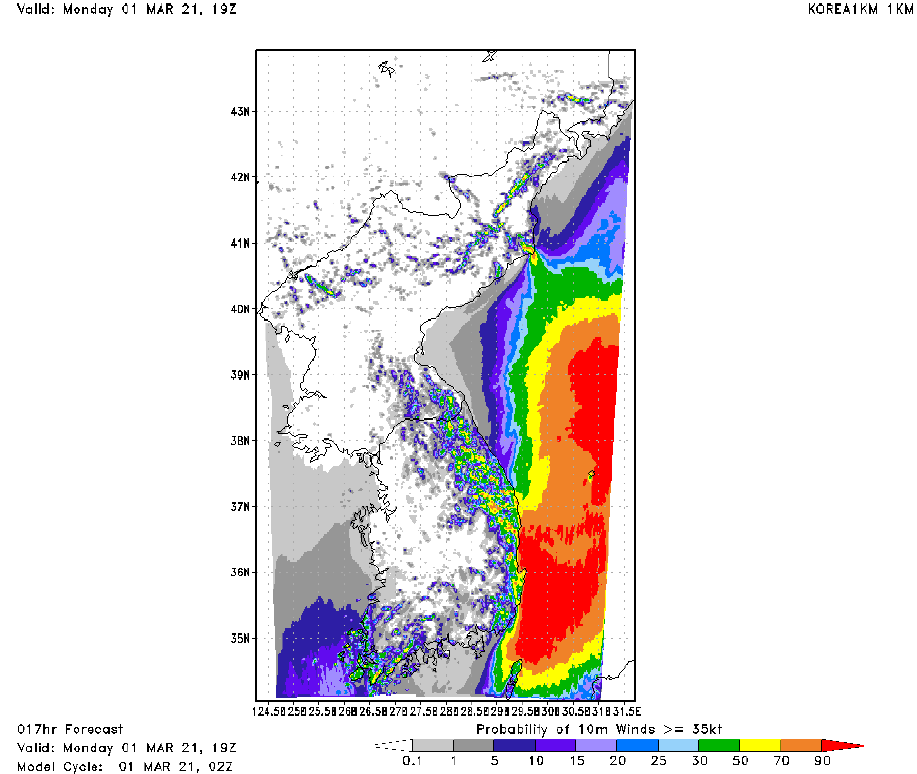
Atmosphere 2021 , 12 , x FOR PEER REVIEW Figure 21. Sample forecast of 1-km MEPS wind gust probabilities (percent) exceeding 35 knots over the Korean Peninsula.